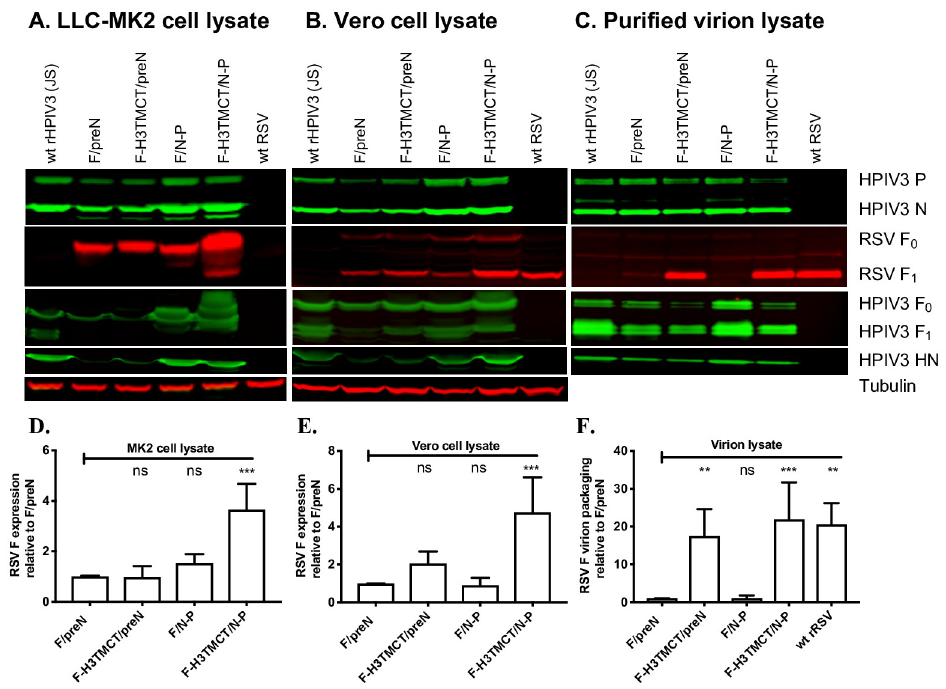
Fig 4. Western blot analysis of infected cell lysates and sucrose gradient-purified virions. (A, B) Analysis of cell- associated proteins. LLC-MK2 (A) or Vero (B) cells were infected with the indicated rHPIV3-RSV-F vectors or wt rHPIV3 at an MOI of 3 TCID 50 /cell or with wt RSV at an MOI of 3 PFU/cell and incubated for 48 h at 32˚C, after which cells were lysed in denaturing and reducing sample buffer and analyzed by Western blotting. RSV F was